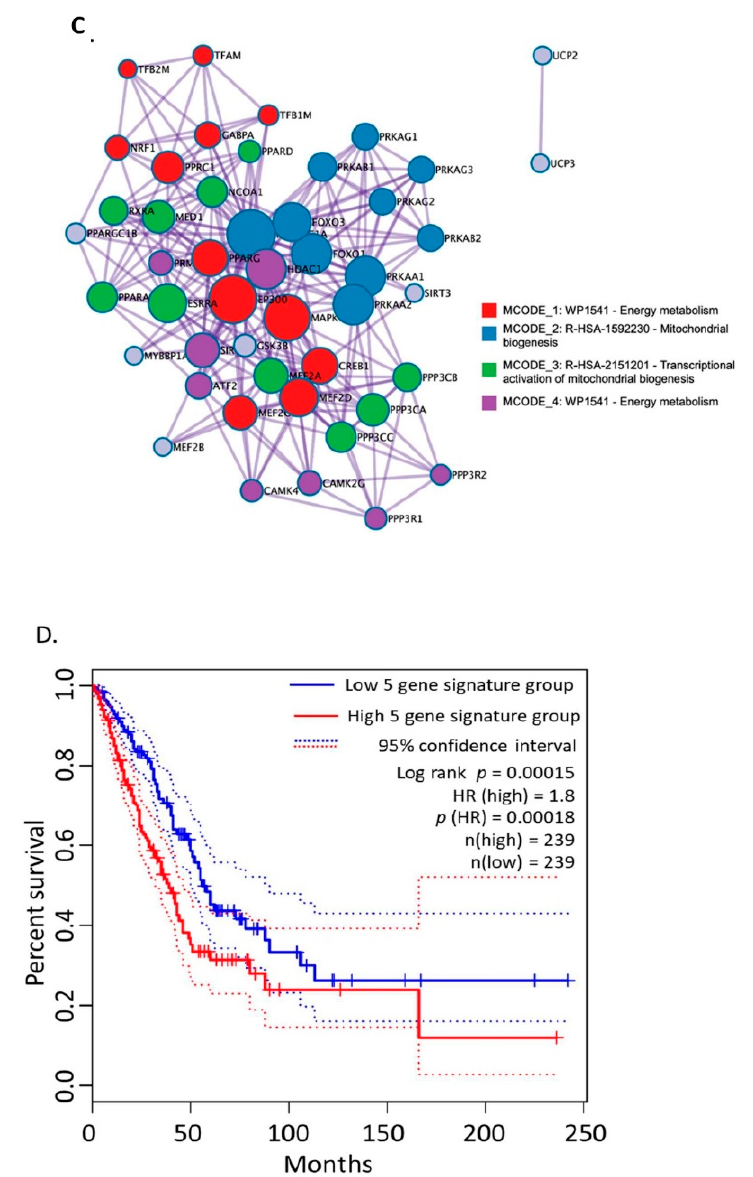
Figure 7. ( A ) Differential expression of WP-energy metabolism genes in LUAD tumor compared to control. ( B ) Network analysis showed distinct genes of energy metabolism, mitochondrial biogenesis and transcriptional activation of mitochondrial biogenesis. ( C ) Immune infiltration analysis showed a higher influx of immunosuppressive cells with the most perturbed genes. ( D ) A five-gene signature from energy metabolism panel showed prognostic significance in the lung cancer dataset.